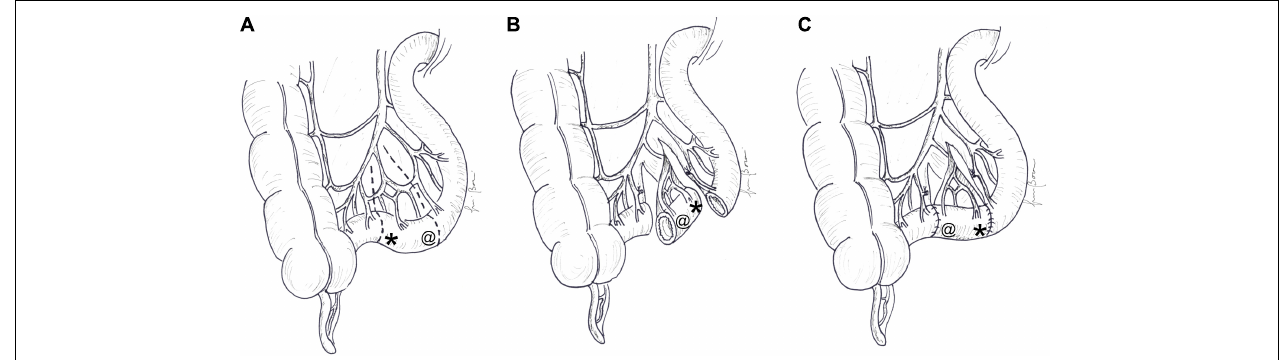
FIGURE 1 | Antiperistaltic reversed segment: (A) a short segment of the small intestine is divided, (B) rotated by 180 ◦ , and (C) re-anastomosed, usually at the distal end of the jejunum. The symbol “*” indicates the original distal end and “@” the original proximal end of the reversed segment. At the end of the procedure, the proximal end (@) becomes distal and the distal end (*) becomes proximal.